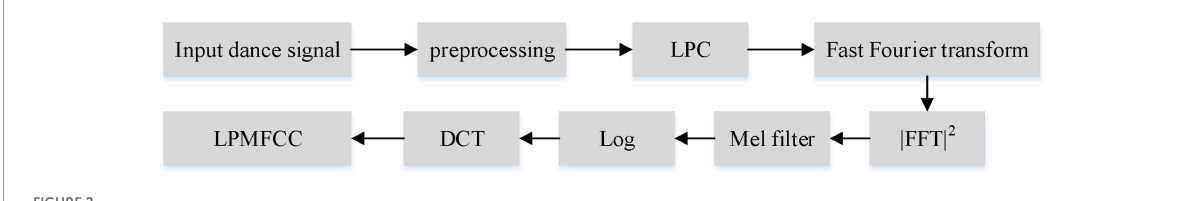
FIGURE2 Feature extraction process of LPMFCC.